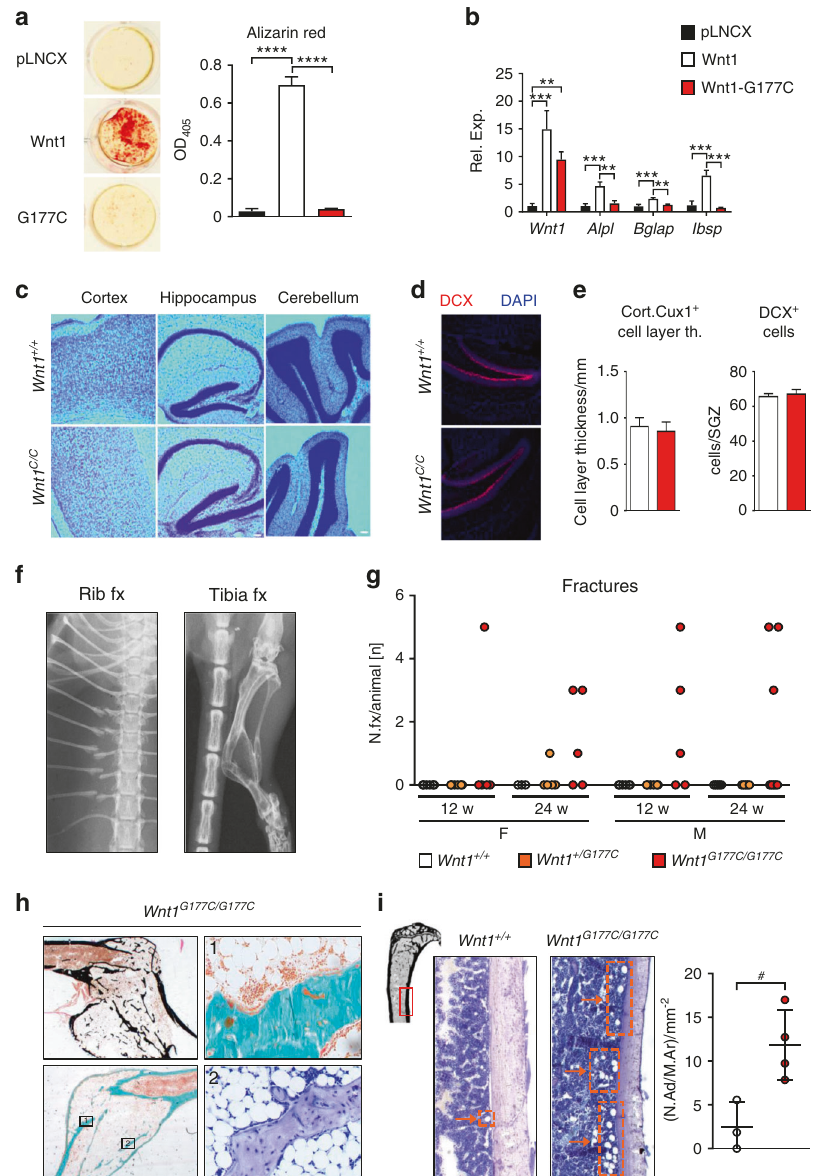
Fig. 2 Wnt1 G177C/G177C mice display a bone-speci fi c phenotype. a Representative images and quanti fi cation of alizarin red staining of ST2 cells transfected with empty vector (pLNCX) and expression plasmids for wild-type ( Wnt1 ) or mutant WNT1 ( G177C ) after 15 days of osteogenic differentiation. n = 3 samples per group. b Expression analysis by qRT – PCR of the indicated genes in ST2 cells transiently transfected with the same plasmids 5 days after transfection. n = 3 samples per group. c Representative Nissl staining of cortex, hippocampus, and cerebellum sections from 4-week-old Wnt1 + / + and Wnt1 G177C/G177C mice. d Representative immuno fl uorescent images of the hippocampus in the same mice. Red: Anti-doublecortin (DCX); Blue: DAPI. e Quanti fi cation of the cortical Cux1-positive cell layer thickness and of the doublecortin- positive neuroblasts in the subgranular zone of the hippocampus. n = 3 animals per genotype. f Representative contact radiographs of spontaneous fractures in 24-week-old Wnt1 G177C/G177C mice. g Number of spontaneous fractures observed per animal in female and male Wnt1 + / + , Wnt1 + /G177C , and Wnt1 G177C/G177C mice at 12 and 24 weeks of age. Each symbol represents an individual mouse. h Histological images of a tibial fracture callus from a 24-week-old Wnt1 G177C/G177C mouse. Top left: von Kossa/van Gieson stain; bottom left: Masson-Goldner stain, squares indicate areas magni fi ed on the right side as indicated by the numbers. Top right: Masson-Goldner stain; bottom right: toluidine blue stain. i Representative images of tibial bone marrow from nonfractured 24-week-old wild-type or Wnt1 G177C/G177C mice and quanti fi cation of the number of bone marrow adipocytes per marrow area (N.Ad/M.Ar). The red rectangle on the symbolic tibia in the top left corner indicates the region depicted in the representative images. Arrows and boxes indicate regions with high numbers of adipocytes. Data were analyzed by one-way ANOVA with Dunnett ’ s multiple comparison test ( a , b ) or Student ’ s t -test ( e , i ). * P < 0.05, ** P < 0.01, *** P < 0.001, **** P < 0.000 1. Error bars indicate standard